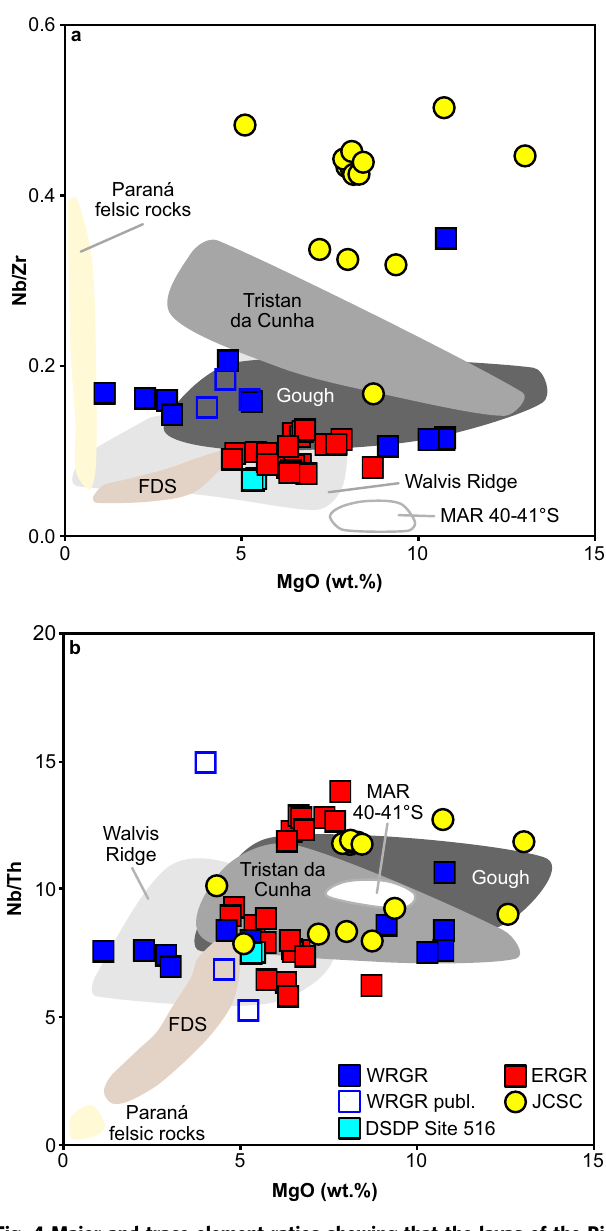
Fig. 4 Major and trace element ratios showing that the lavas of the Rio Grande Rise exhibit no clear geochemical indications for assimilation with continental crust. Major and trace element variations of a MgO versus Nb/Zr and b MgO versus Nb/Th are shown. For comparison lava fl ows from the Walvis Ridge 15,52 and the ocean islands of Tristan da Cunha and Gough 53 – 56 are shown. Further, we considered geochemical compositions of previously dredged samples from the Western Rio Grande Rise (WRGR) 18,20 , glasses from South Atlantic Mid-Ocean Ridge Basalt (MORB) 57 and crustally contaminated lavas from the Florianopólis Dyke Swarm 36 (FDS) for comparison. The fi eld of the Paraná felsic rocks include the Paulo Lopes Granites and Garopaba Granodiorites 35